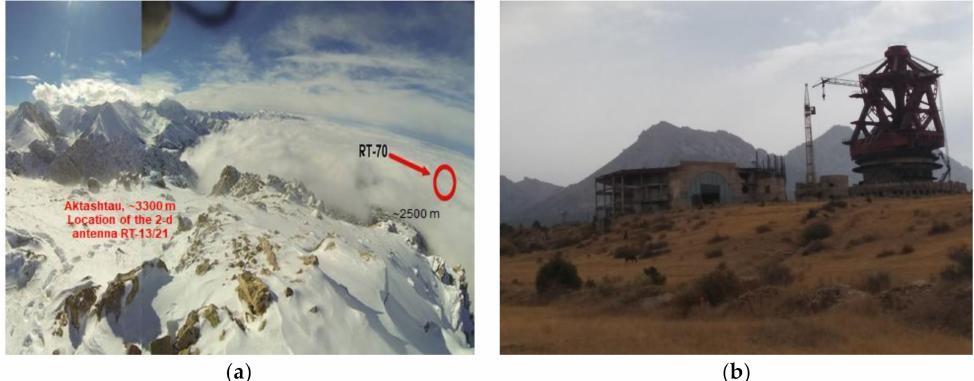
Figure 6. Suffa Plateau (2400 m) and Aktashtau mountains (3200 m): views ( a ) from Aktashtau to RT-70 in clouds and ( b ) Aktashtau from the RT-70 location (the left one).